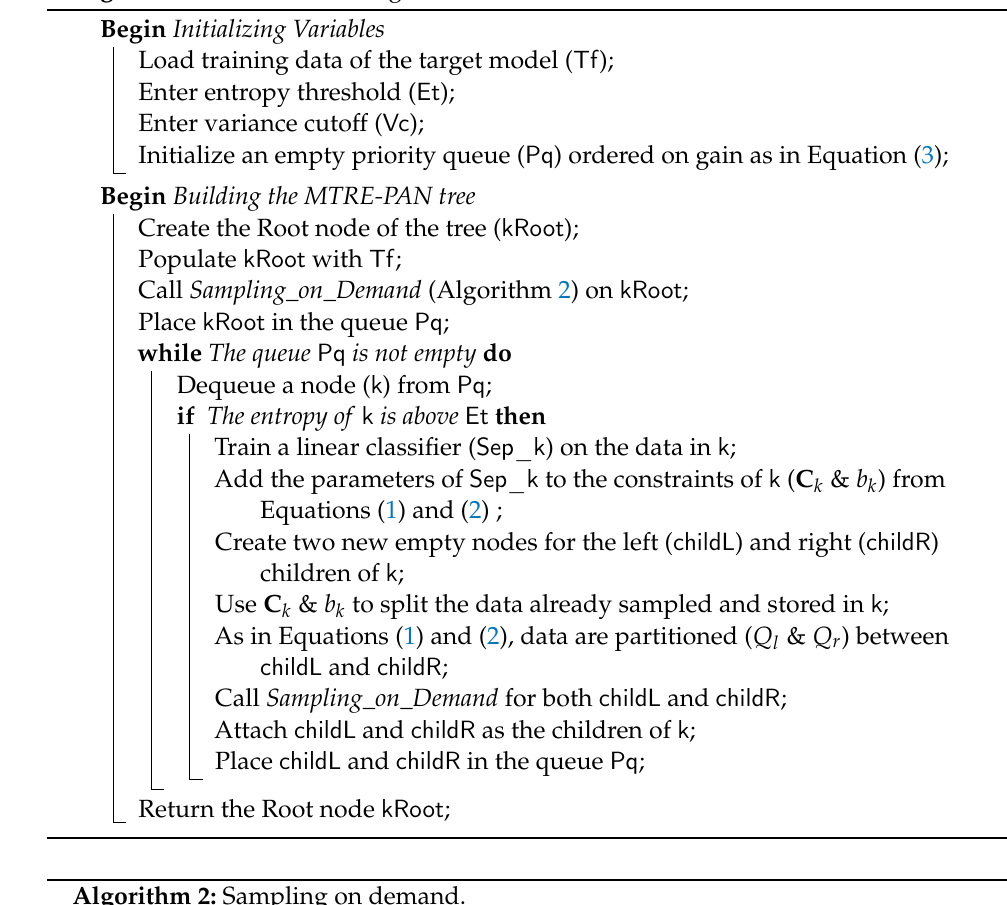
Algorithm 1: M-TRE-PAN